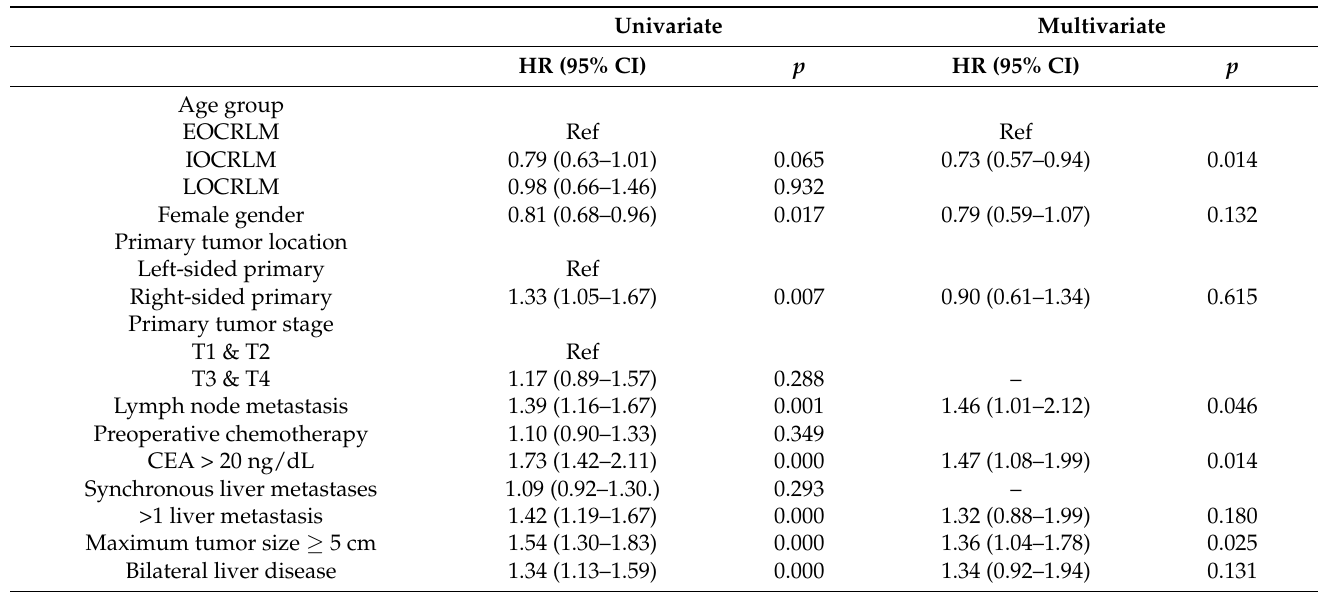
Figure 2. Overall survival among the different age groups before ( A ) and after ( B ) the IPTW. Due to the potential difference among the three groups, IPTW was performed to weight the imbalanced characteristics (sex, primary tumor location, N stage, Ras status, bilobular disease, largest tumor size, number of nodules, extrahepatic disease, CEA level, major hepatectomy, intraoperative transfusion, R1 resection, and received preoperative or adjuvant chemotherapy), and three new comparable cohorts were created. The characteristics of the weighted cohorts are shown in Table S2. The median survival time in the IOCRLM cohort (46 months) was also approaching significant longer than the median survival time in the EOCRLM cohort (37 months) ( p = 0.065 Figure 2B). In addition, multivariate analysis suggested that IOCRLM ( p = 0.014), positive lymph nodes in the primary ( p = 0.045), RAS mutation ( p = 0.000), a tumor size larger than 5 cm ( p = 0.025), CEA > 20 ( p = 0.014), extrahepatic metastasis ( p = 0.016), and a positive resection margin ( p = 0.010) were independent predictors of OS (Table 2). Table 2. Univariate and multivariable Cox regression analysis of overall survival in the entire cohort after IPTW.